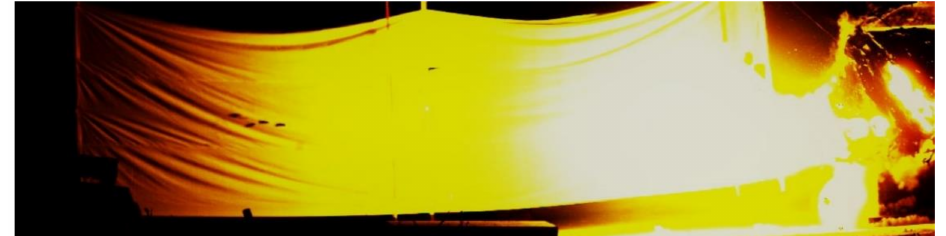
Figure 10. High-speed photography screenshots of the fourth dynamic test (4#).